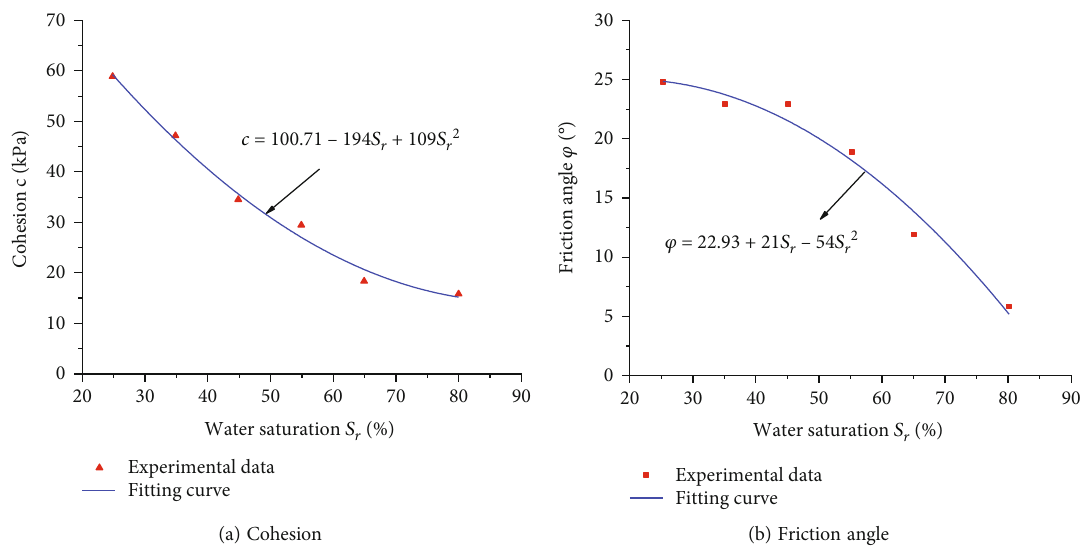
Figure 5: Experimental results and the fi tting curve of the Tanjiawan landslide.